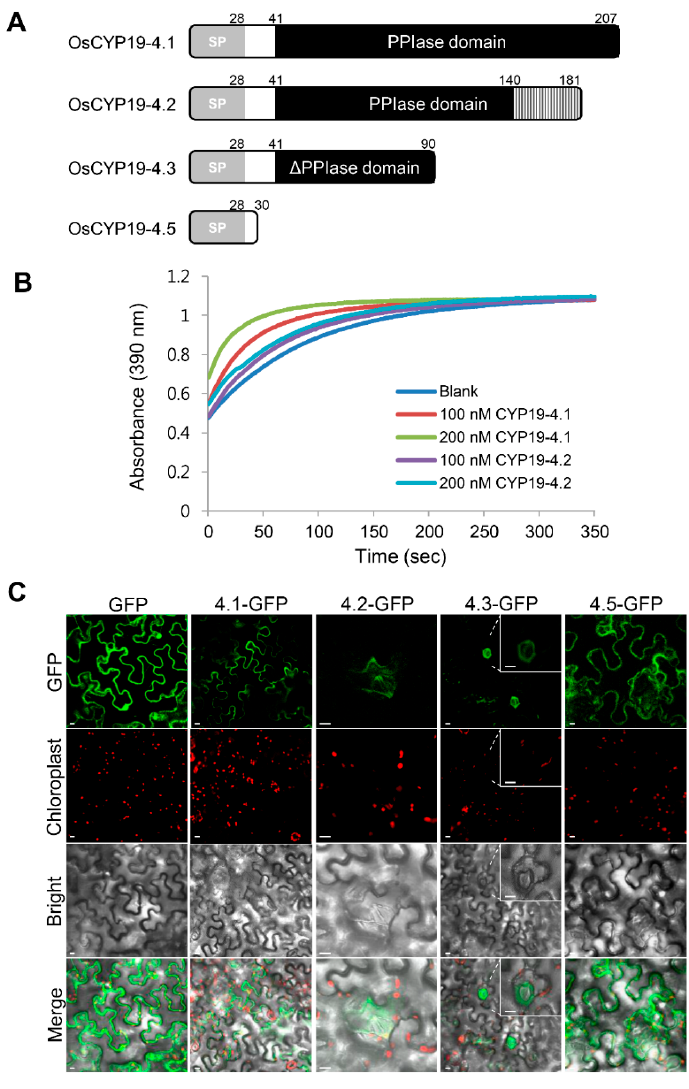
Figure 3. Characteristics of OsCYP19-4 AS isoform proteins. ( A ) Domain structures of AS isoform proteins. SP, signal peptides; PPIase domain, peptidyl prolyl cis/trans isomerase domain; ∆ PPIase domain, deleted peptidyl prolyl cis/trans isomerase domain. Numbers indicate amino acids; ( B ) PPIase activity of recombinant OsCYP19-4.2 AS protein. Curves represent isomerization of the Suc-AAPF-pNA substrate at 10 ˝ C over the course of 300 s in the absence of OsCYP19-4 (Blank; blue) and in the presence of 100 nM (OsCYP19-4.1: red; OsCYP19-4.2: purple) or 200 nM (OsCYP19-4.1: green; OsCYP19-4.2: sky blue) recombinant proteins; absorbance was measured at 390 nm; ( C ) Subcellular localization of GFP-fused fully spliced and AS OsCYP19-4 proteins. GFP fluorescence and chlorophyll autofluorescence are shown in green and red color, respectively. Merged images show GFP and chloroplast fluorescence. Bright field images show epidermal cells of Nicotiana benthamiana infected with Agrobacterium GV3101 harboring OsCYP19-4.1-GFP (4.1-GFP), OsCYP19-4.2-GFP (4.2-GFP), OsCYP19-4.3-GFP (4.3-GFP), or OsCYP19-4.5-GFP (4.5-GFP). Scale bars = 10 µ